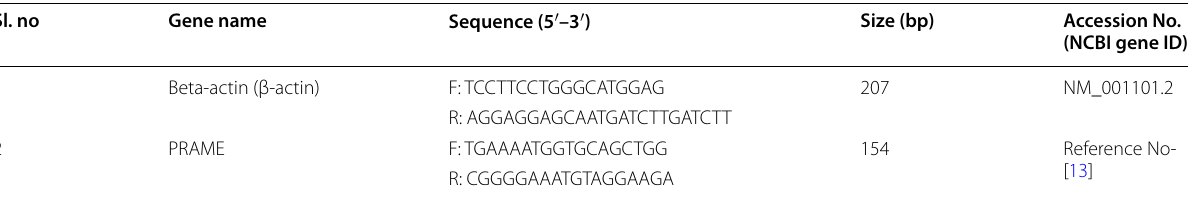
Table 1 List of genes with primer sequences, size, and accession numbers Sl.